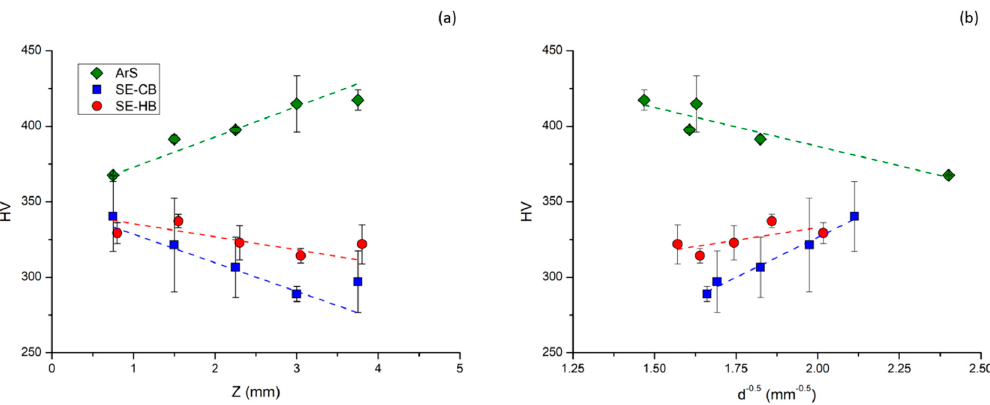
Figure 8. Micro-Vickers hardness with relative linear interpolation for all conditions plotted as a function of Z ( a ) and relative Hall-Petch plot ( b ).